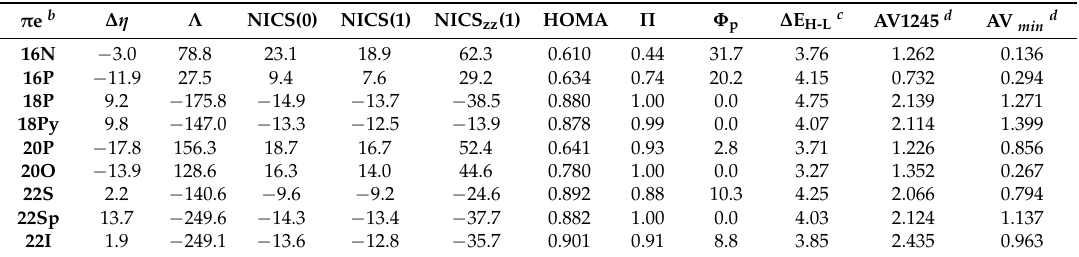
Table 1. Energetic, reactivity, magnetic, structural and electronic properties of unsubstituted porphyrinoids a